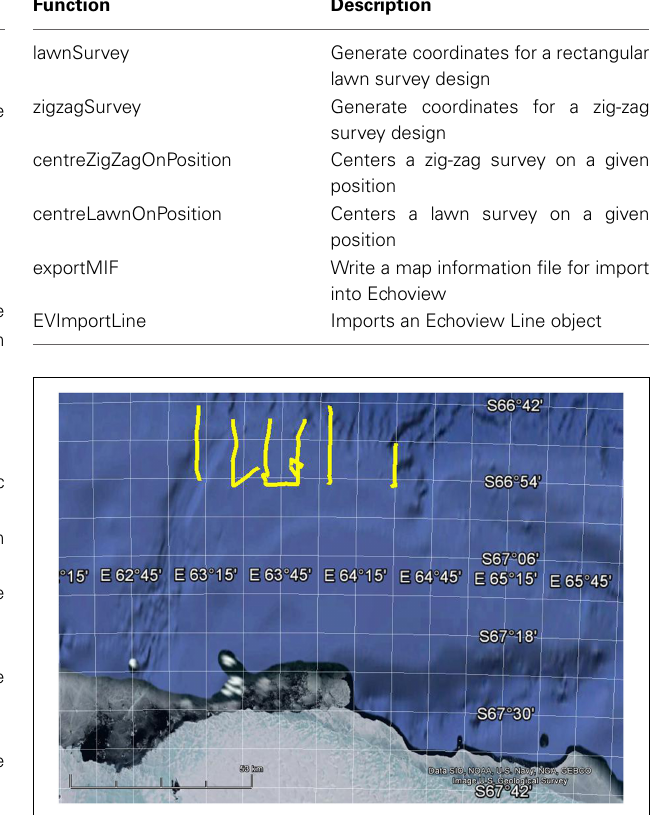
FIGURE 1 | Map showing location of 6 the example transects in yellow. Map created using Google Earth